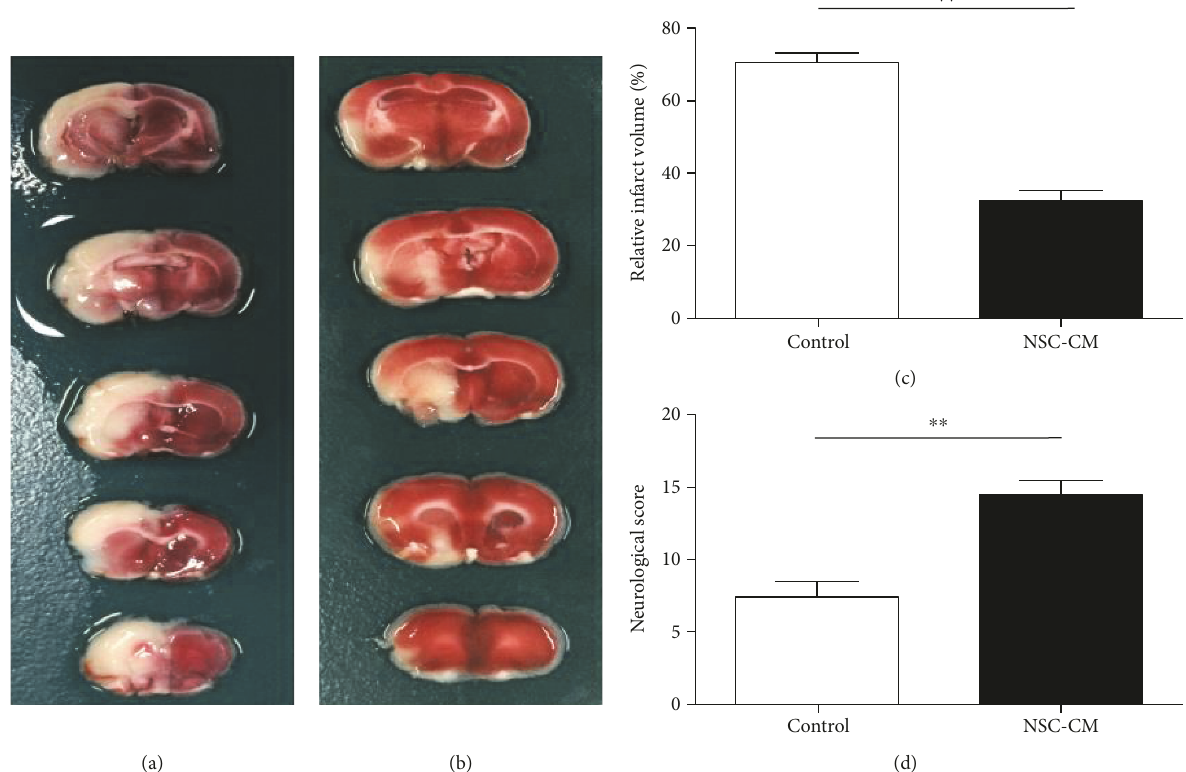
Figure 1: The e ff ect of NSC-CM on the neurological defect score and cerebral infarct volume of cerebral ischemia/reperfusion injury. Representative TTC staining image on the 3rd day after cerebral ischemia onset of the control group (a) and the NSC-CM group (b). The bar graph showing that the percentage of cerebral ischemic volume (c) in the hemisphere ipsilateral to the lesion on the 3rd day after cerebral ischemia onset was signi fi cantly decreased by posttreatment with NSC-CM compared with the control group ( n = 5 each group). ∗∗ P < 0 01 , two-sample t test. The bar graph showing that NSC-CM (d) signi fi cantly improved the neurological defect score according to a 21-score point, compared to control. ∗∗ P < 0 01 , two-sample t